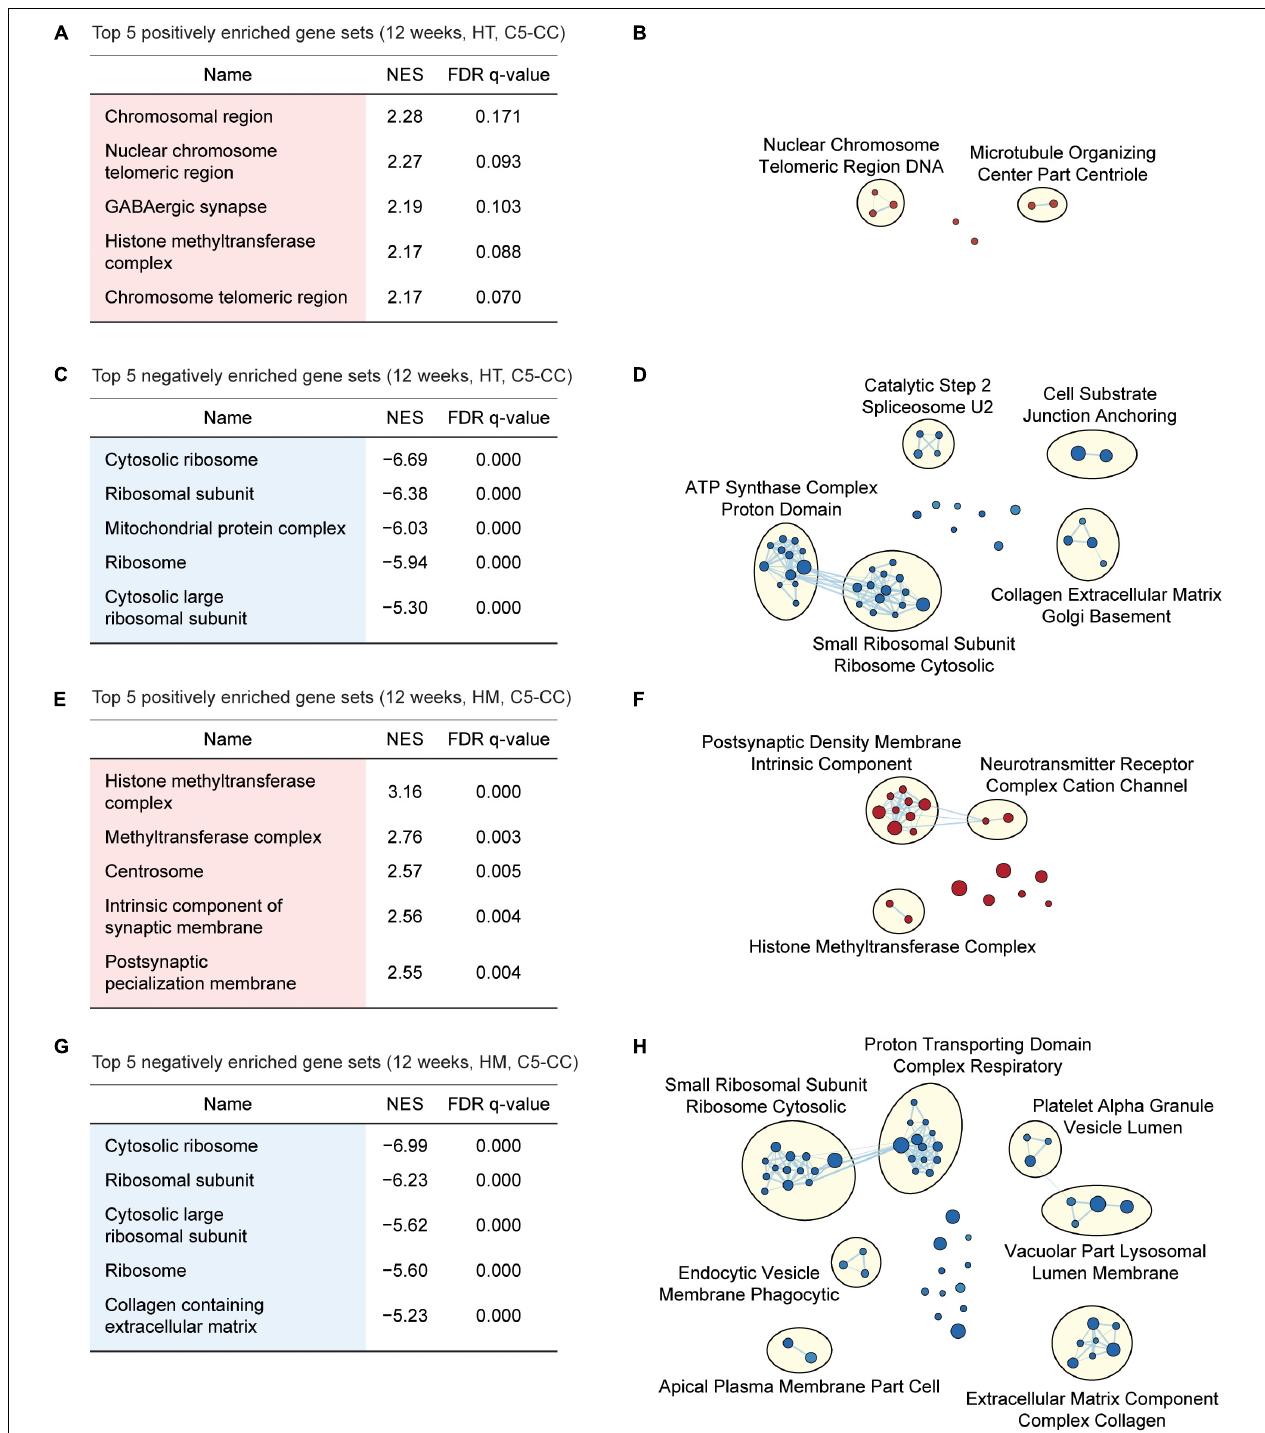
FIGURE 4 | GSEA of transcriptomes from W12-HT and W12-HM Shank2 -mutant mice for biological functions. (A–D) GSEA results for W12-HT transcripts showing the list of top five positively (red) and negatively (blue) enriched gene sets (A,C) and their integrated visualization using EnrichmentMap Cytoscape App (B,D) . See Supplementary Figures 6 , 7 for GSEA results for C5-BP and C5-MF ( n = 4 mice for WT, HT, and HM, FDR < 0.05). (E–H) GSEA results for W12-HM transcripts (E,G) and their integrated visualization generated using EnrichmentMap (F,H) ( n = 4 mice for WT, HT, and HM, FDR < 0.05). See Supplementary Figures 8 , 9 for GSEA results for C5-BP and